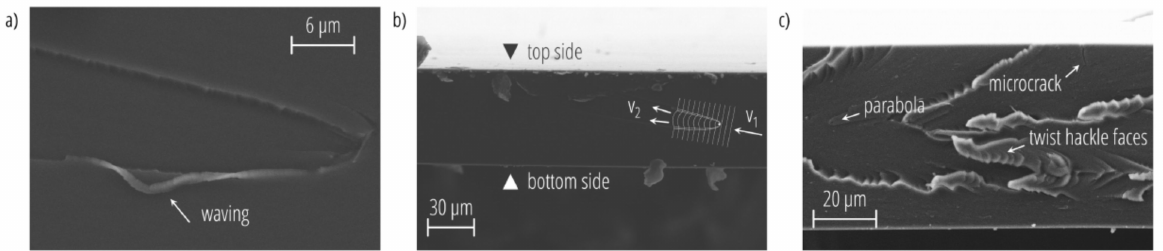
Figure 18. Selected SEM images of the fracture surfaces ( a , b ) in the absence of cellulose nanocrystals; ( c ) nanocomposite with 0.5 wt. % cellulose nanocrystals (used with copyright permissions)